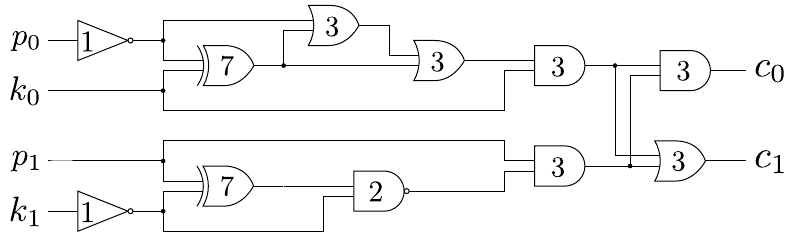
Figure 1: Toy encryption circuit with two plaintext inputs p 0 , p 1 , two key inputs k 0 , k 1 and two ciphertext outputs c 0 , c 1 . The numbers within the logic gates denote their propagation delay in time delay units ( tdu